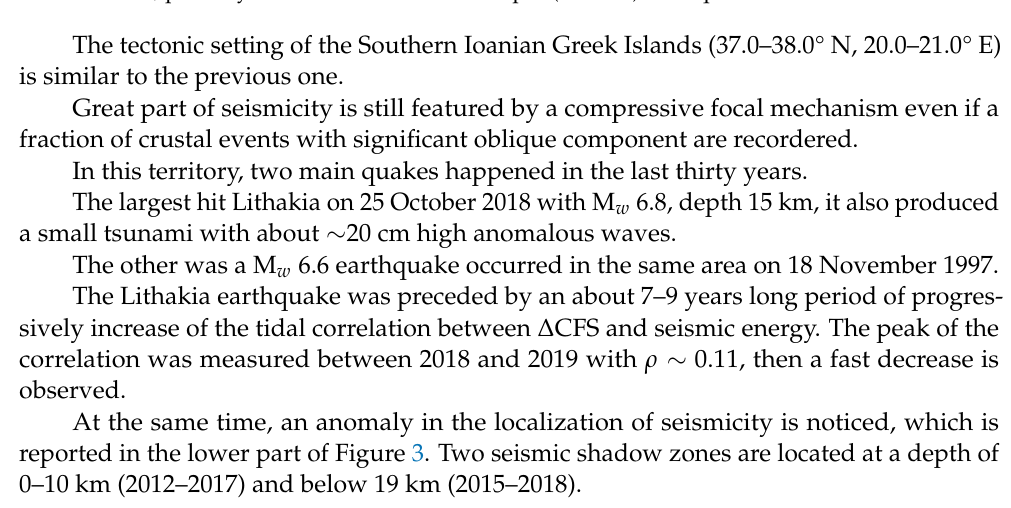
Figure 2. ( Top ) correlation between ∆ CFS and seismicity close to the Greek Ionian coasts (38.0– 39.0° N, 20.0–21.0° E, M L > 2.0, NOAIG Catalog.) between 1990 and 2021. Main event was located in southwestern region of Lefkada Island between the villages Athani and Agios Petros. The 2014–2016 seismic sequence involved faults within different tectonic settings. ( Bottom ) ∆ CFS as a function of time. Before the 2014–2016 seismic sequence, significant changes in the Coulomb stress distribution was observed, partially due to contribution of deeper (>20 km)